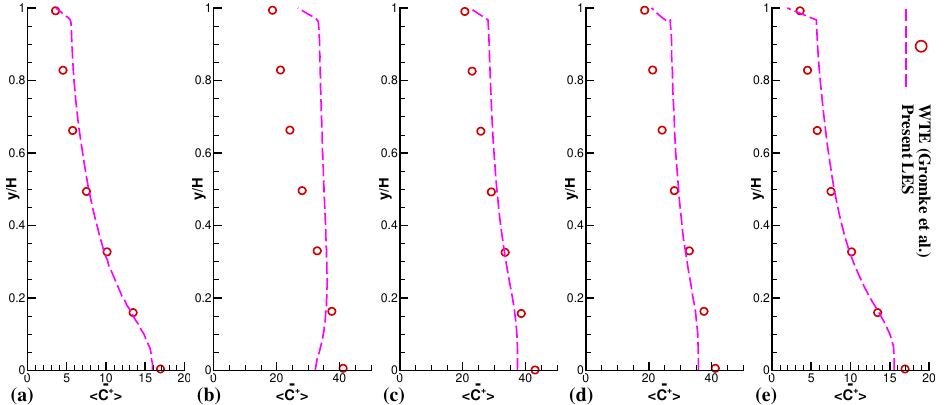
+ (cid:105) profiles at five separate spanwise